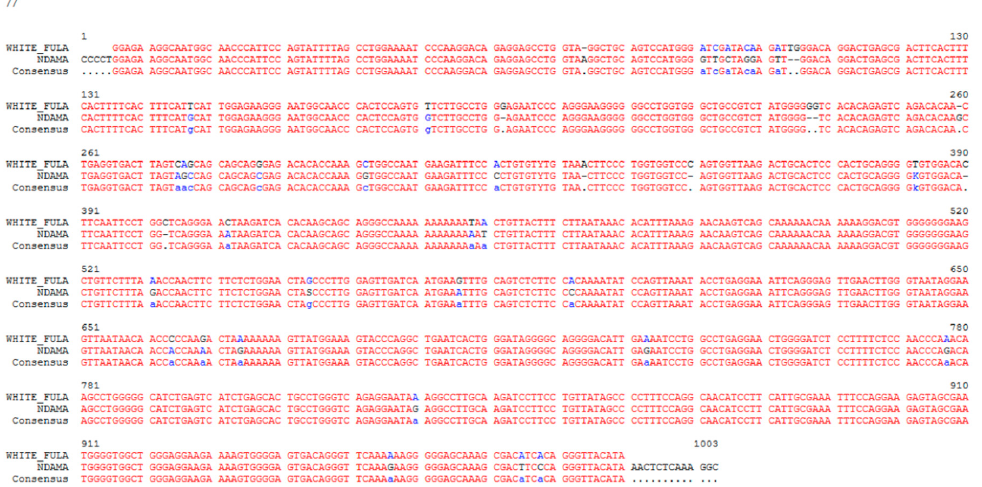
Figure 1. Alignment of the CD14 gene promoter nucleotide sequences of N’Dama and White Fulani. Blue letters within alignment indicate sites of sequence diversity between animal breeds.